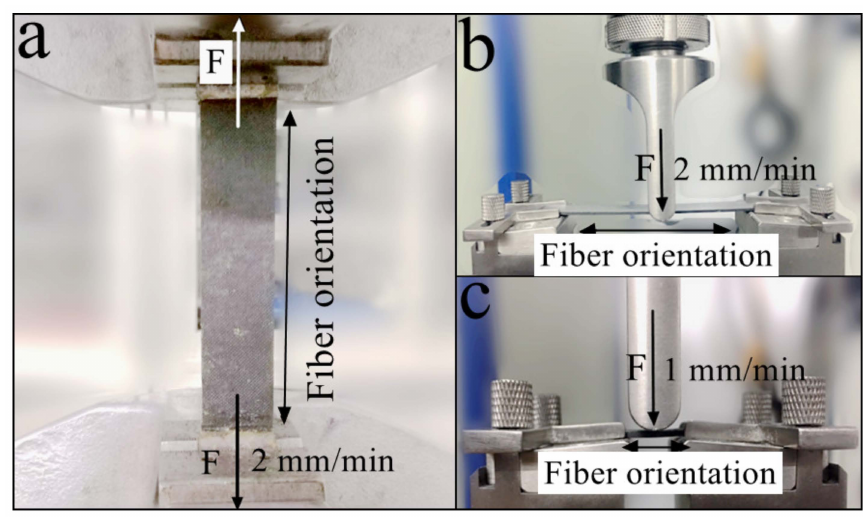
Figure 6. The specimen dimensions and operational specifications during ( a ) the tensile test, ( b ) the three-point bending test, and ( c ) the interlaminar shear